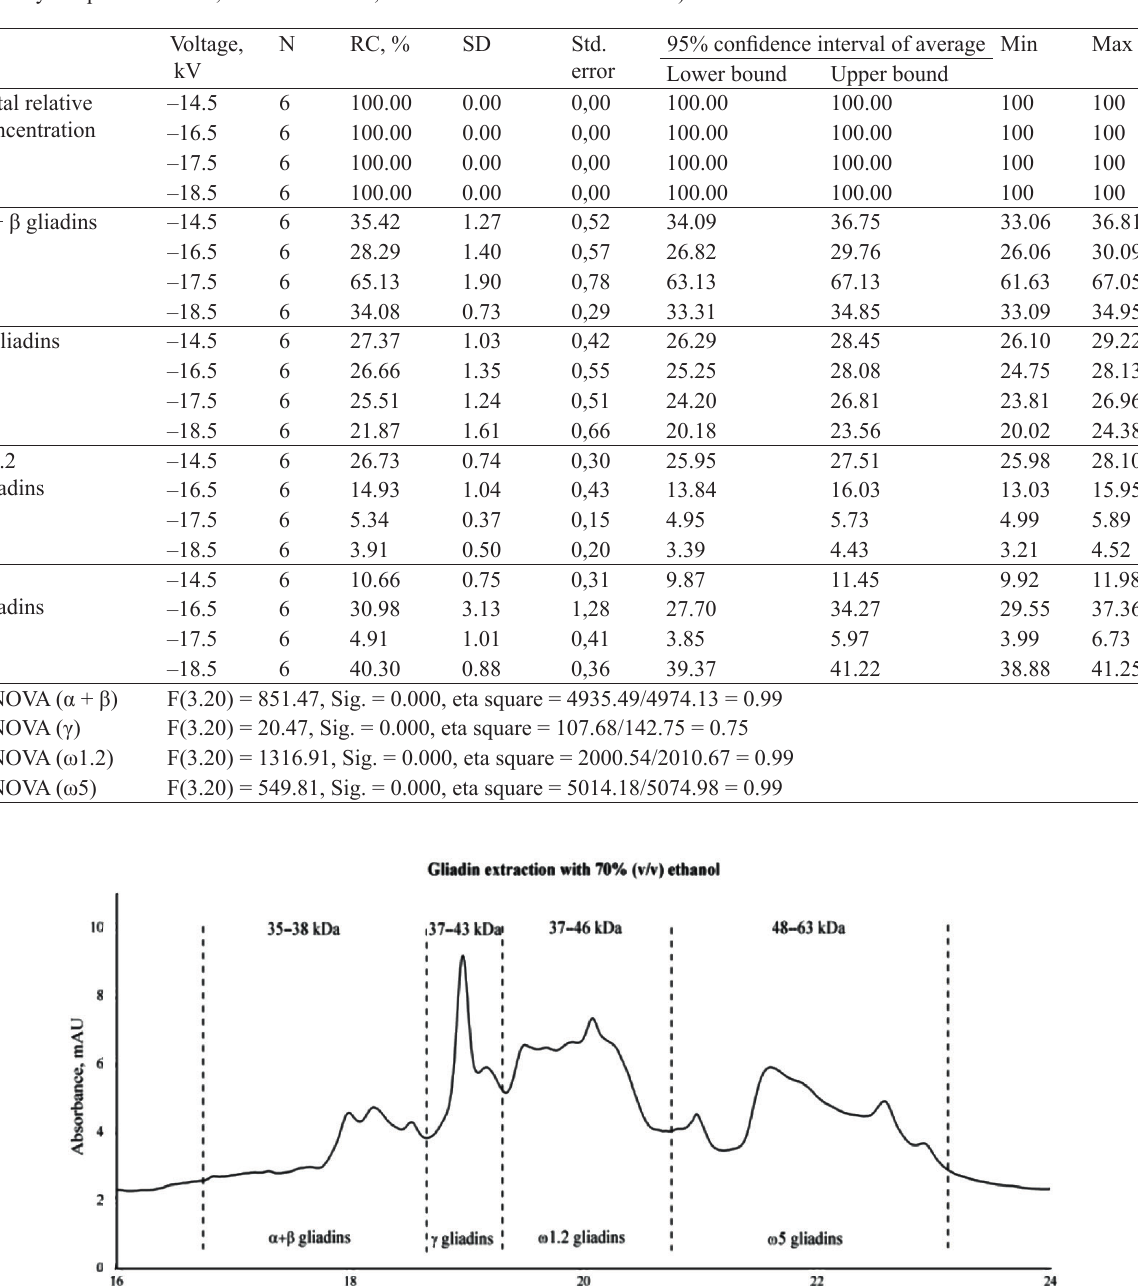
Table 7 Descriptive indicators of the relative concentration of proteins and relative concentration of gliadin fractions (solvent 70% ethanol, Agilent, CE 7100, capillary inside diameter 50 µm, total capillary length 33 cm, effective capillary length 23.50 cm, capillary temperature 25°C, duration 30 min, absorbance measured at 220 nm)